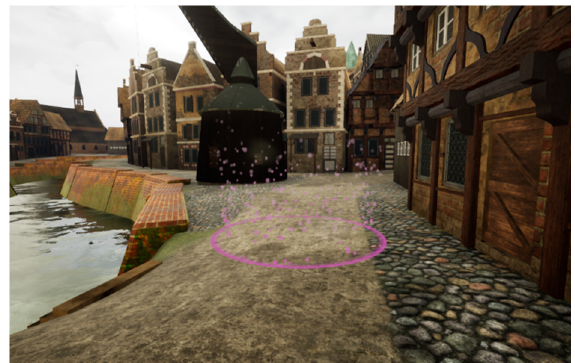
Figure 10. 3D animated widget notifying user of the presence of a panoramic photo, in location corresponding to panorama photo in Figure